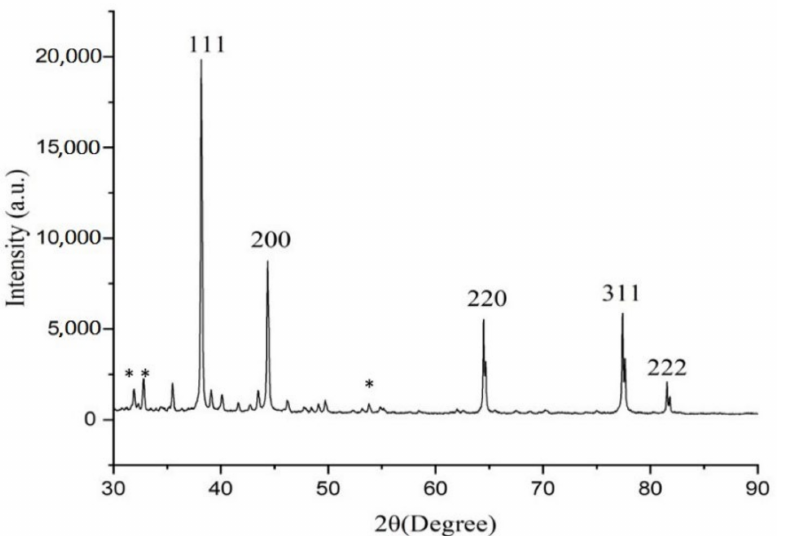
Figure 4. XRD pattern of AgNPs. Star (*) symbol represents small not indexed peaks such as 32.31 ◦ , 32.80 ◦ and 54.97 ◦